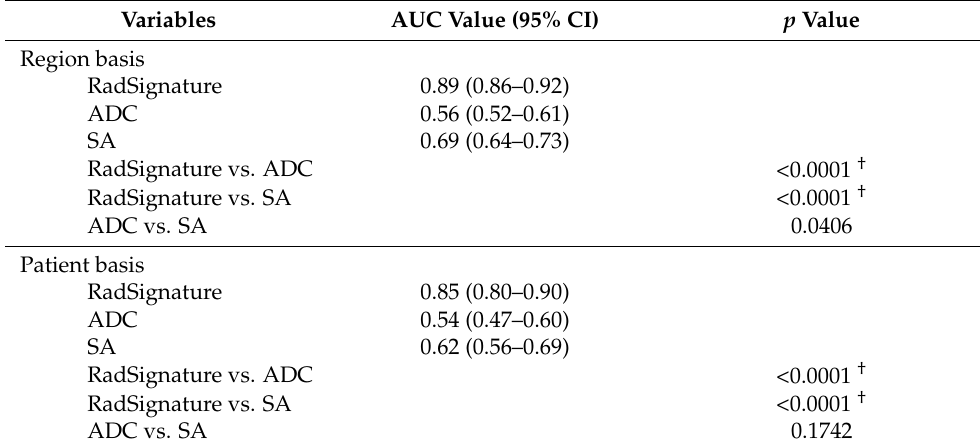
Table 4. Pairwise comparisons of ROC curves in detecting pelvic lymph node